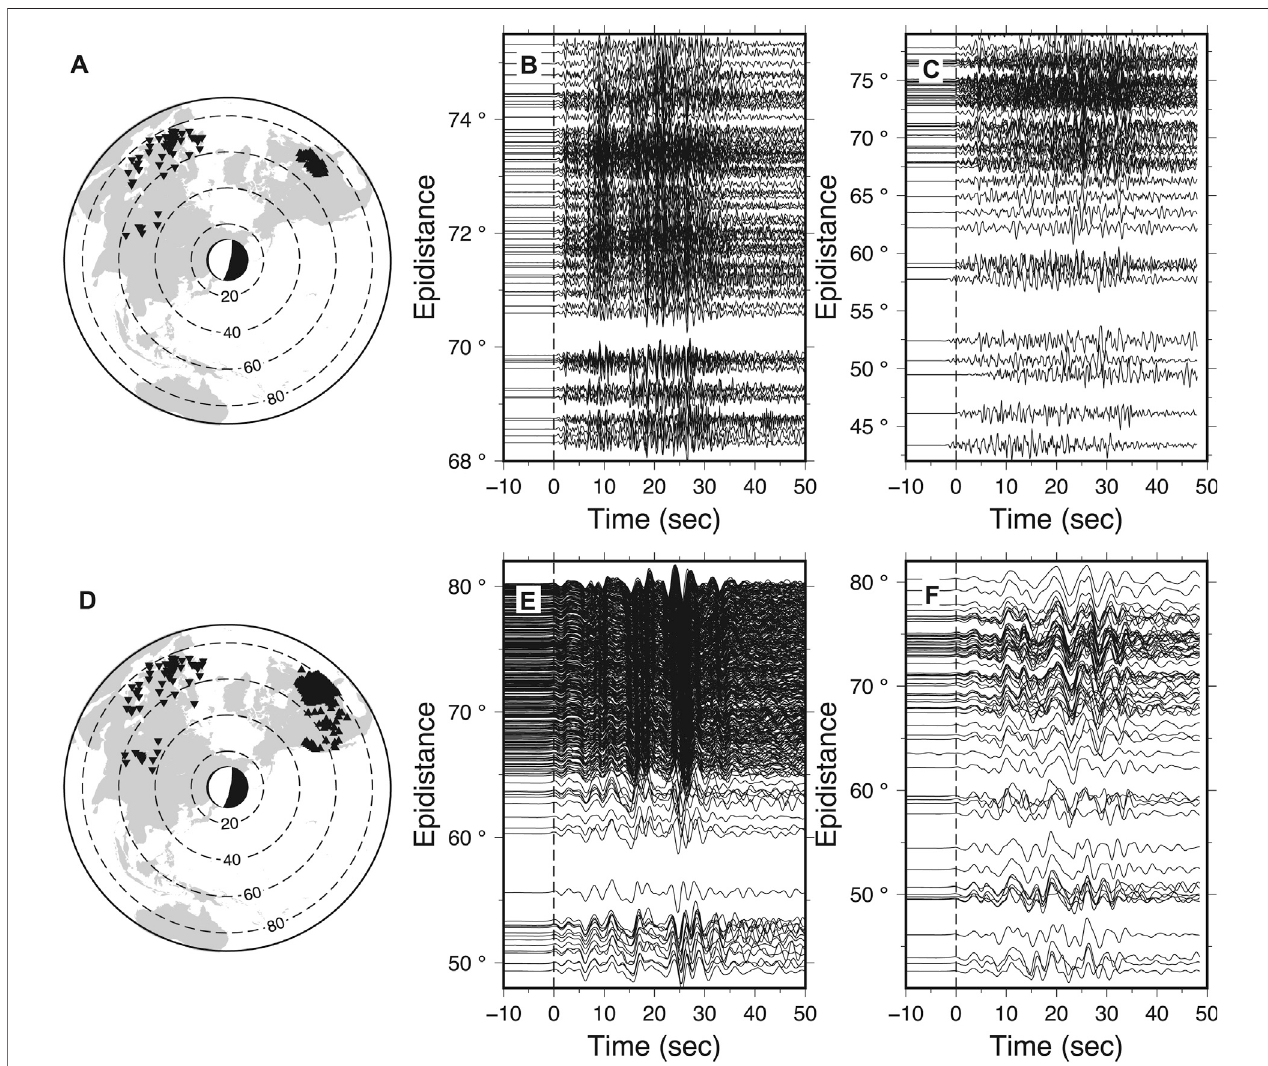
FIGURE 1 | Station distribution of the TA (triangles) and the EU (inverse triangles) arrays for (A) the high- and (D) low-frequency bands. P- wave trains are aligned with the fi rst arrival (dashed lines) at the TA fi ltered in (B) the high- (0.5 – 2 Hz) and (E) low- (0.1 – 0.5 Hz) frequency bands, and at the EU in (C) the high- and (F) low- frequency bands. The P waveform ’ s polarities are reversed at the TA. The GCMT focal mechanism is placed at the epicenter of the 2013 Sea of Okhotsk deep-focus earthquake.